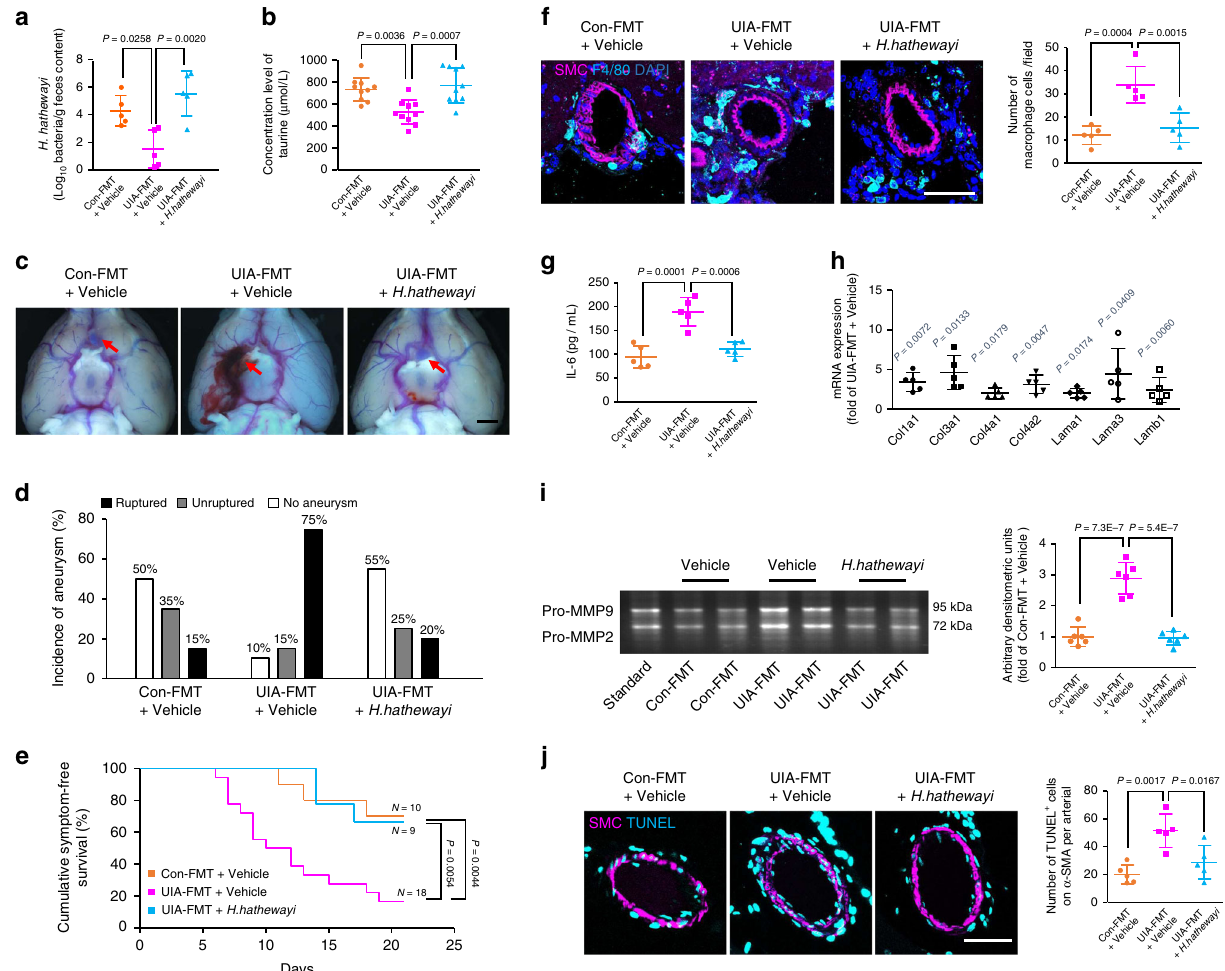
Fig. 8 H. hathewayi protects against the intracranial aneurysms. a Quantitative PCR detection of H. hathewayi in fecal DNA in each group ( n = 5). b Serum concentrations of taurine in each group measured by UHPLC-MS/MS analyses ( n = 10; one-way ANOVA with the Bonferroni post hoc test). c Representative images of intracranial aneurysms in UIA patients and controls that received fecal microbiota transplantation (FMT), followed by oral gavage with H. hathewayi and aneurysm induction with angiotensin II and elastase (arrows, intracranial aneurysms; scale bar, 1 mm). d Incidence of unruptured and ruptured aneurysms 21 days after aneurysm induction ( n = 20). e Cumulative symptom-free curves for mice with aneurysms to show the time course of symptom onset ( n = 10 for control-FMT + Vehicle group, n = 18 for UIA-FMT + Vehicle group, n = 9 for UIA-FMT + H. hathewayi group; log-rank (Mantel-Cox) test). f Representative images and quanti fi cation of F4/80 + macrophage immunostaining surrounding CD31 + cerebral vessels (scale bar, 50 μ m). g Concentration of IL-6 in serum measured by ELISA. h Quantitative PCR showing the expression of pivotal components of arterial structure ( n = 5; Student ’ s unpaired two-tailed t-test or Mann – Whitney U test with the exact method). i Representative gelatin zymography and quantitative analysis of the MMP-9 activity in cerebral vessels from each group ( n = 6; one-way ANOVA with the Bonferroni post hoc test). j Representative images and quanti fi cation of α -SMA + vascular smooth muscle cell apoptosis in each group (scale bar, 50 μ m). Data are the mean ± SD. For ( a ), ( f ), ( g ), and ( j ), n = 5; one-way ANOVA with the Bonferroni post hoc test. Source data are provided as a Source Data fi